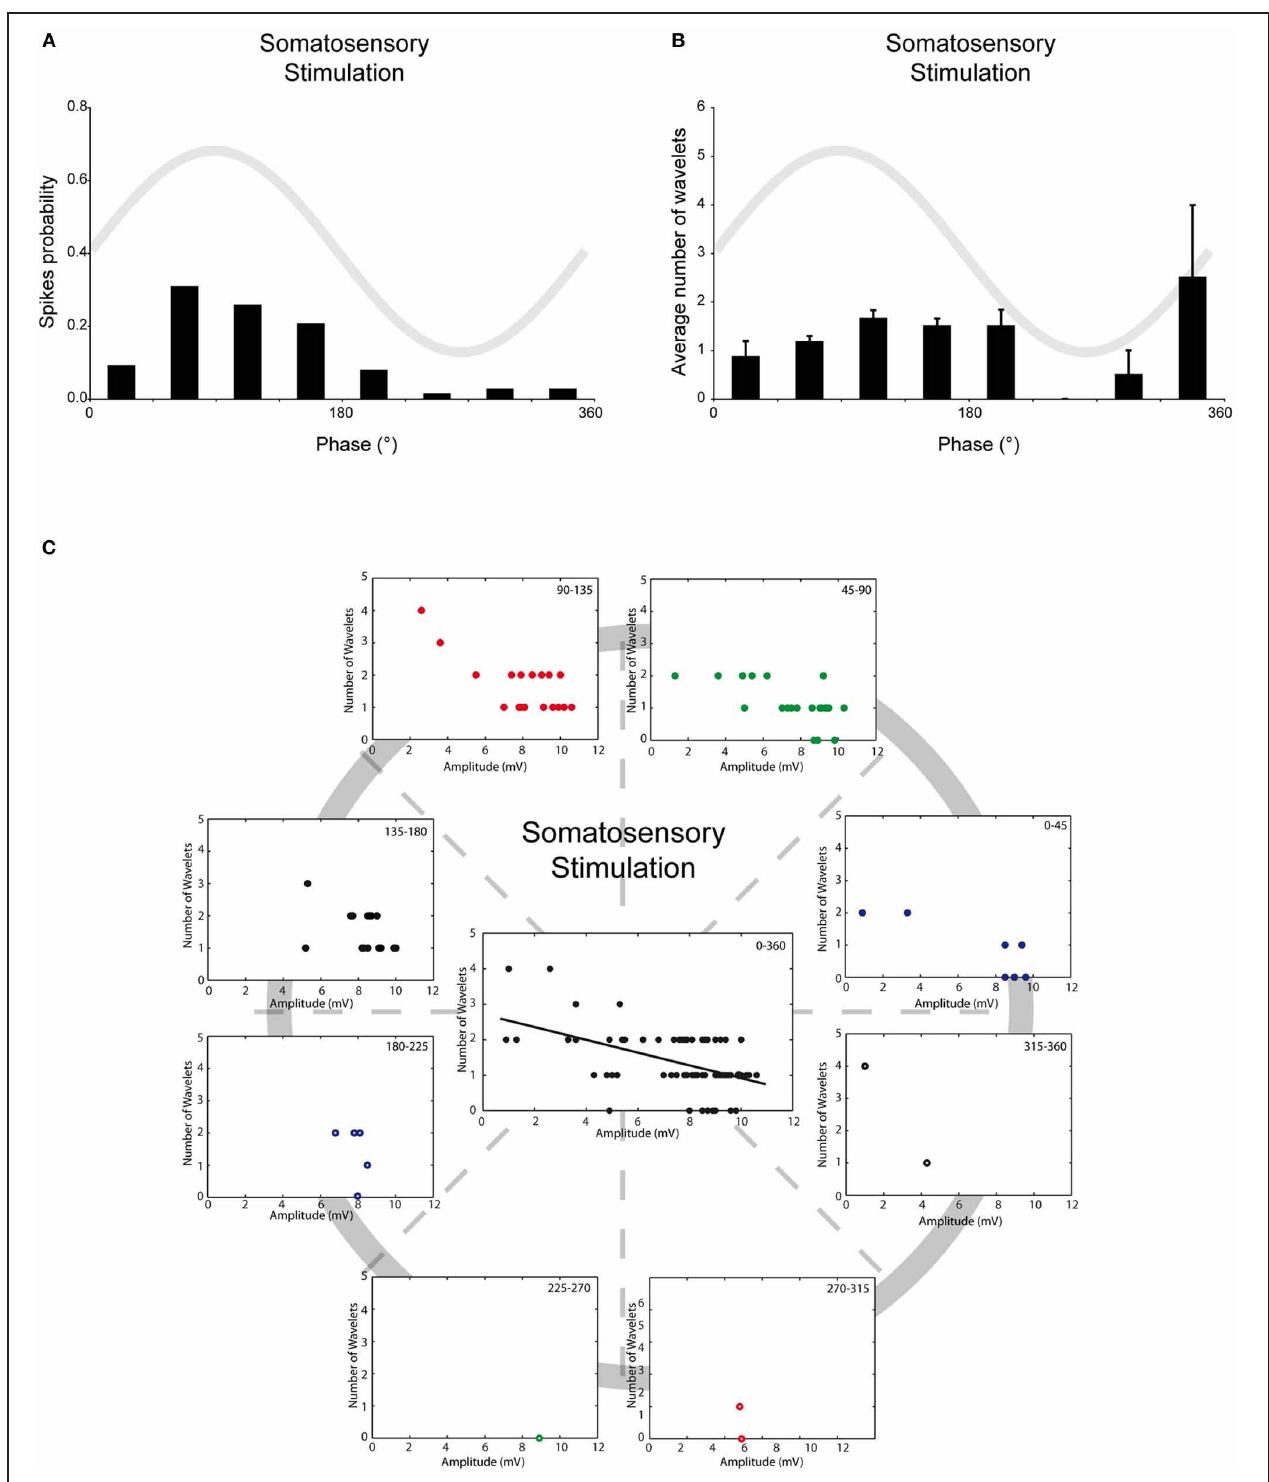
FIGURE 4 | Burst size of olivary wavelets and SSTOs of somatosensory-evoked spikes. (A) The occurrence of stimulus evoked spikes (spike probability) in relation to the phase of the SSTO obtained from olivary neurons recorded under KX anaesthesia ( n = 78). (B) Average number of wavelets on the ADP of stimulus evoked spikes in relation to the phase of the SSTO obtained from olivary neurons recorded under KX anaesthesia